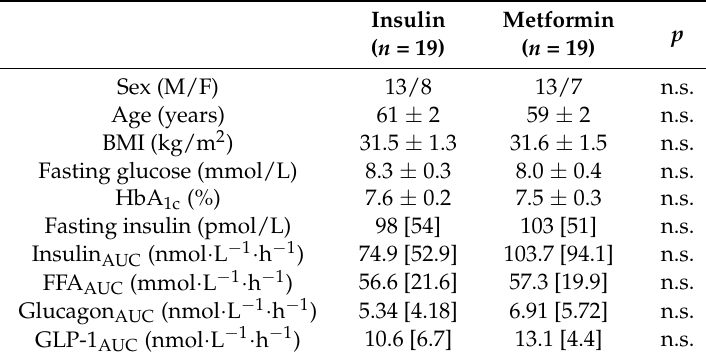
Table 1. Clinical and metabolic characteristics.